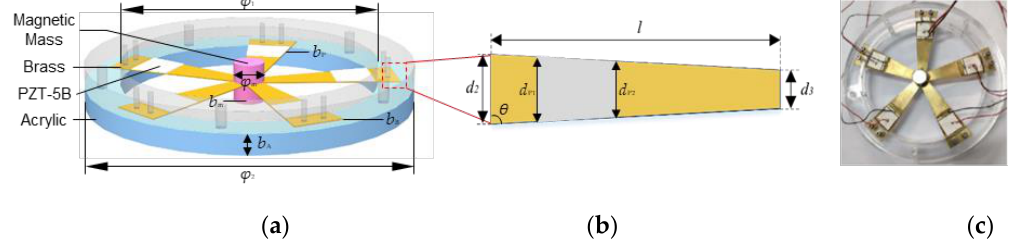
Figure 1. Schematic diagram of the SPEH. ( a ) Simulation schematic diagram of SPEH structure. ( b ) Dimensions of a single trapezoidal brass sheet. ( c ) Experimental prototype of SPEH vibrator. Table 1. Dimensions of the SPEH components.